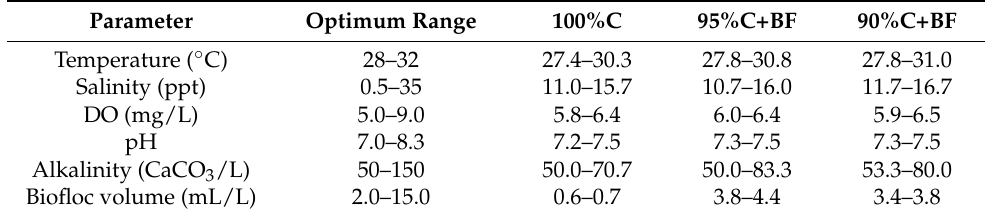
Table 1. Water quality parameters for six weeks shrimp grow-out